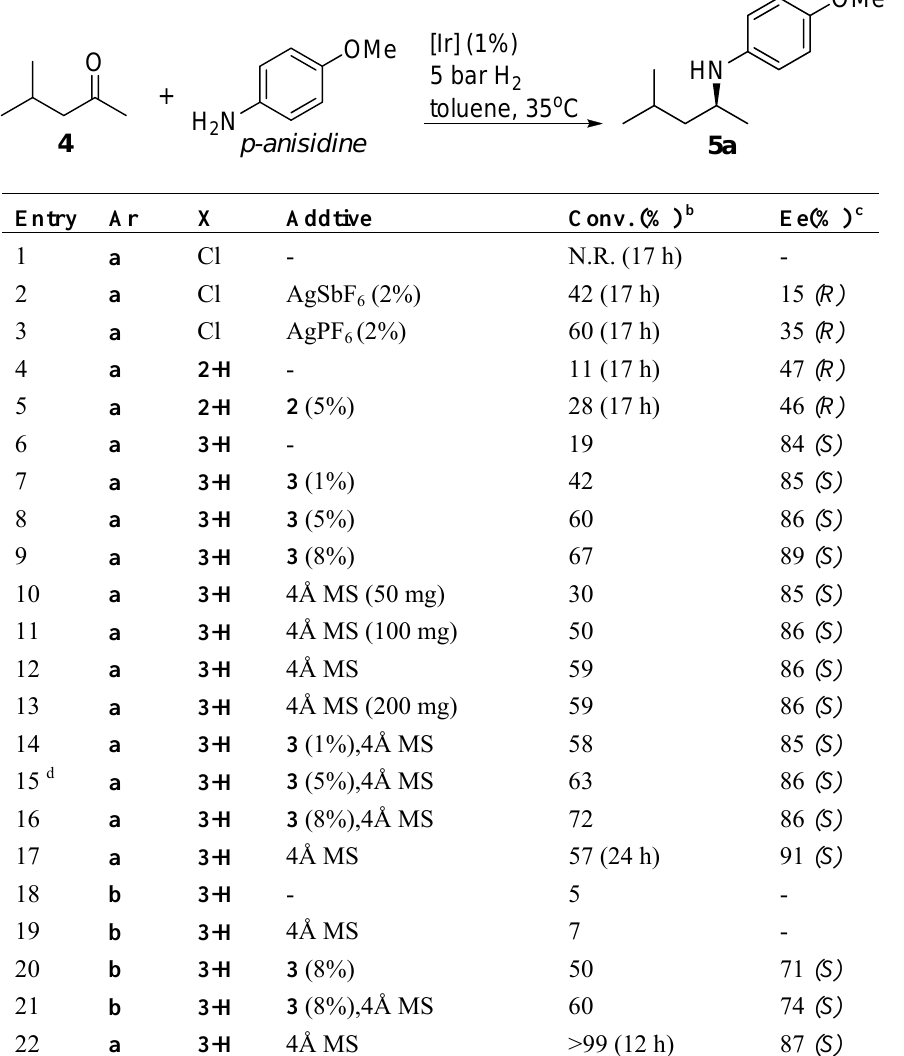
Table 1. Optimisation of conditions for the DARA of 4-methylpentan-2-one ( 4 ). a